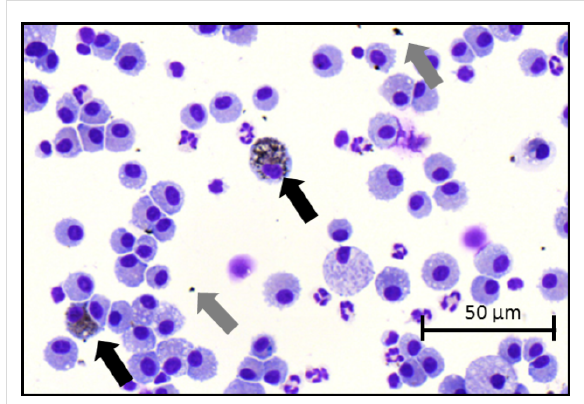
Figure 8: Representative BAL cell image after the intratracheal instilla- tion of 250 µg PVP-AgNP. Gray arrows indicate free particles; black arrows indicate alveolar macrophages with internalized